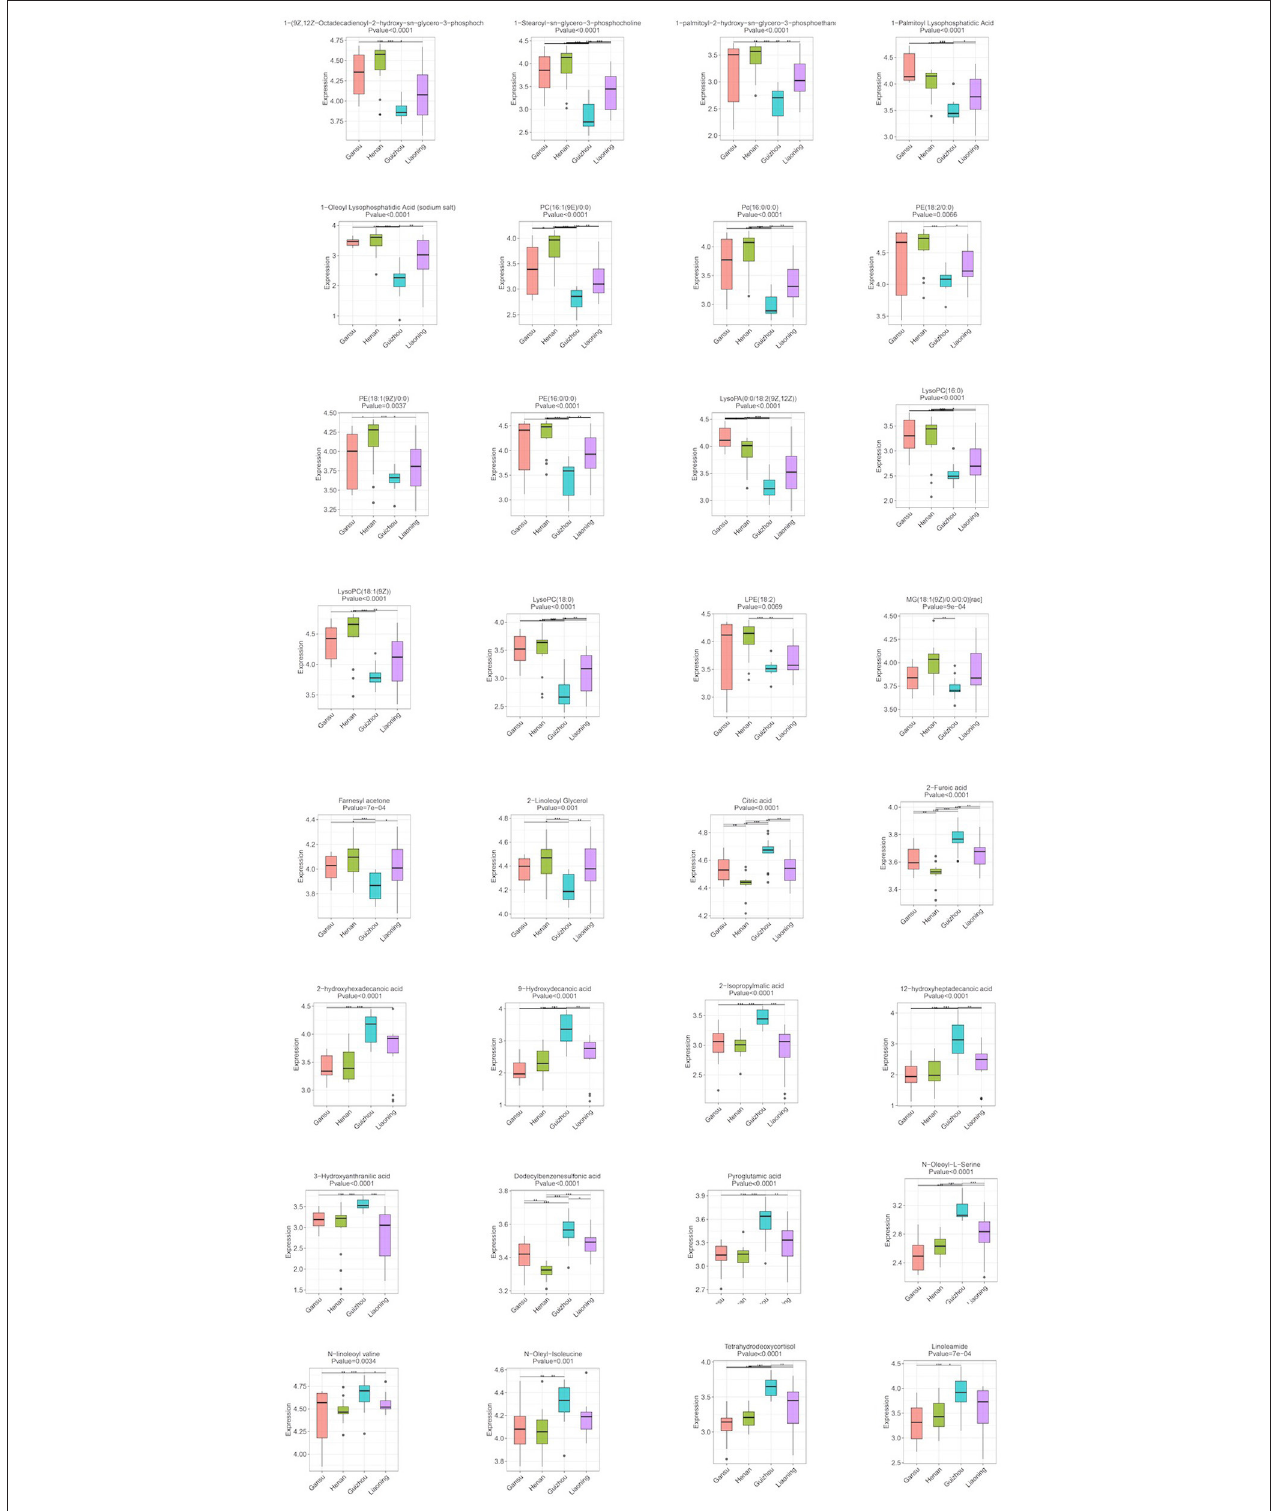
FIGURE 4 | Boxplots of the normalized peak area of differential metabolites for morels samples from different geographical origins: Gansu, Henan, Guizhou, and Liaoning. Data are expressed as mean ± SD; * p < 0.05, ** p < 0.01, and *** p < 0.001.